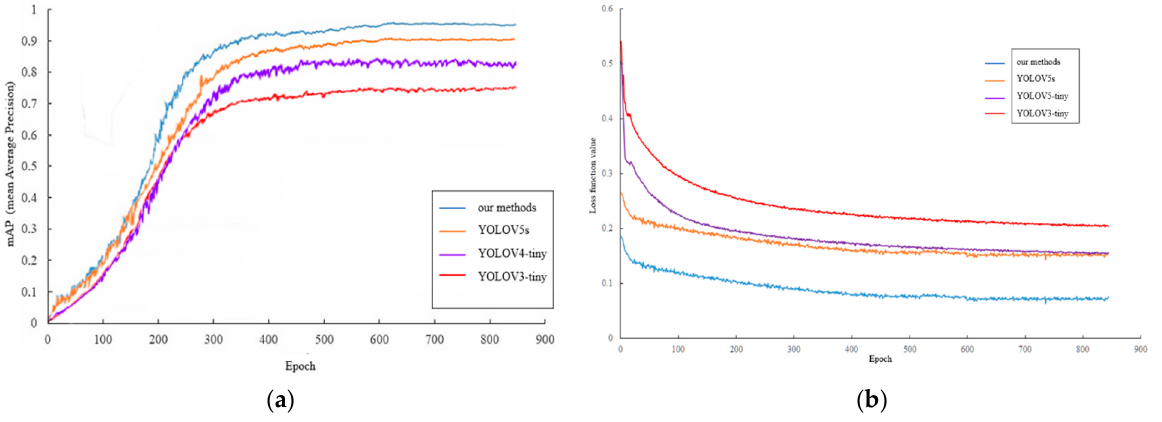
Figure 14. Comparison of different detection models. ( a ) mAP curve; ( b ) Loss curve.